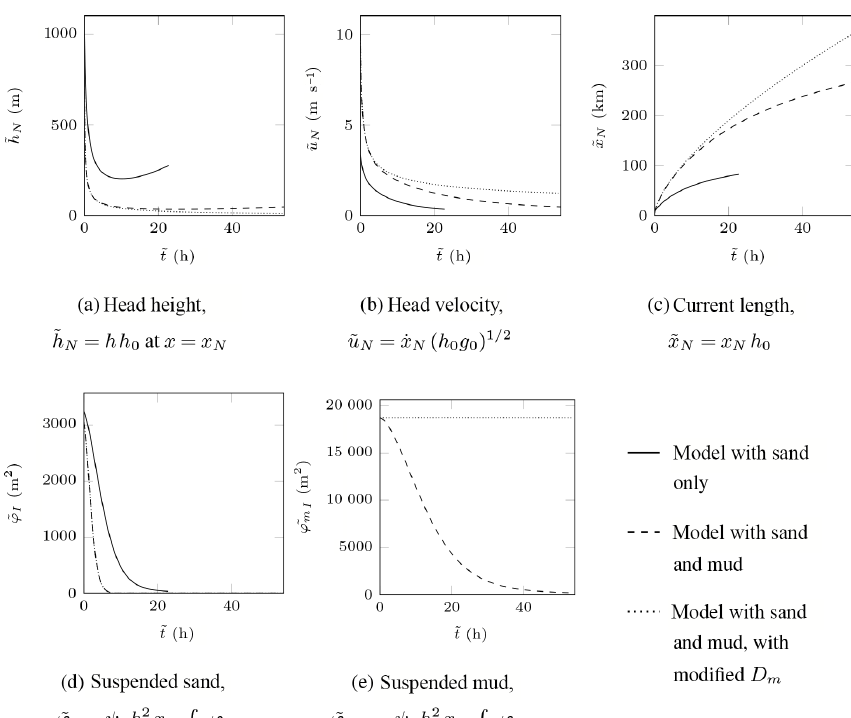
Figure 12. The time evolution of the dimensionalised variables for three simulations: a simulation with a single sand sediment class and optimised input parameters to match the Bed 1.1 sand deposit, a simulation with sand and mud classes and optimised input parameters to match the Bed 1.1 sand deposit, and a simulation with sand and mud classes and the same optimised input parameters but a mud diameter 2 orders of magnitude smaller. The results are shown against the dimensional time, e t = t (h 0 /g 0 ) 1 / 2